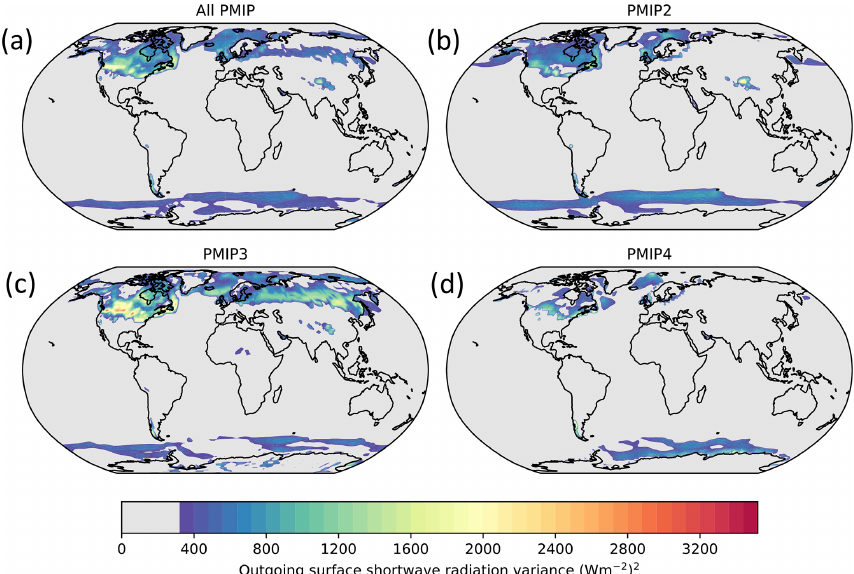
Figure 6. Maps of the variance in outgoing (reflected) surface shortwave radiation in the multi-model ensembles of (a) all PMIP generations, (b) PMIP2, (c) PMIP3, and (d) PMIP4. Variance values which are below less than 10% of the maximum value are masked in gray, to highlight areas of high variance.